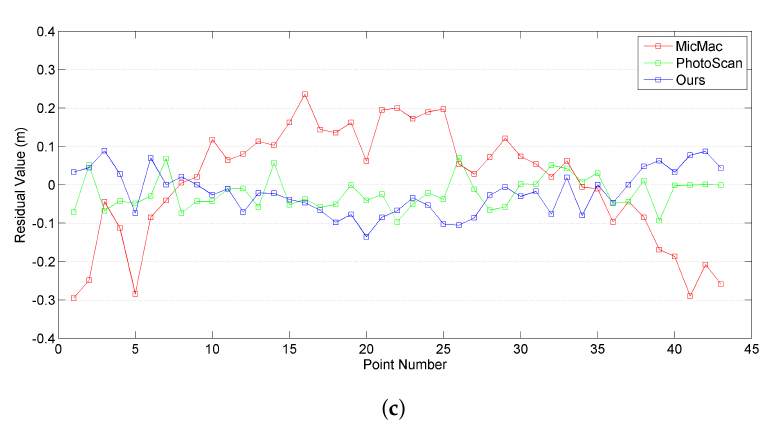
Figure 16. Individual residuals for bundle adjustment tests of dataset 2 with GCPs: ( a ) x -direction; ( b ) y -direction; ( c ) z